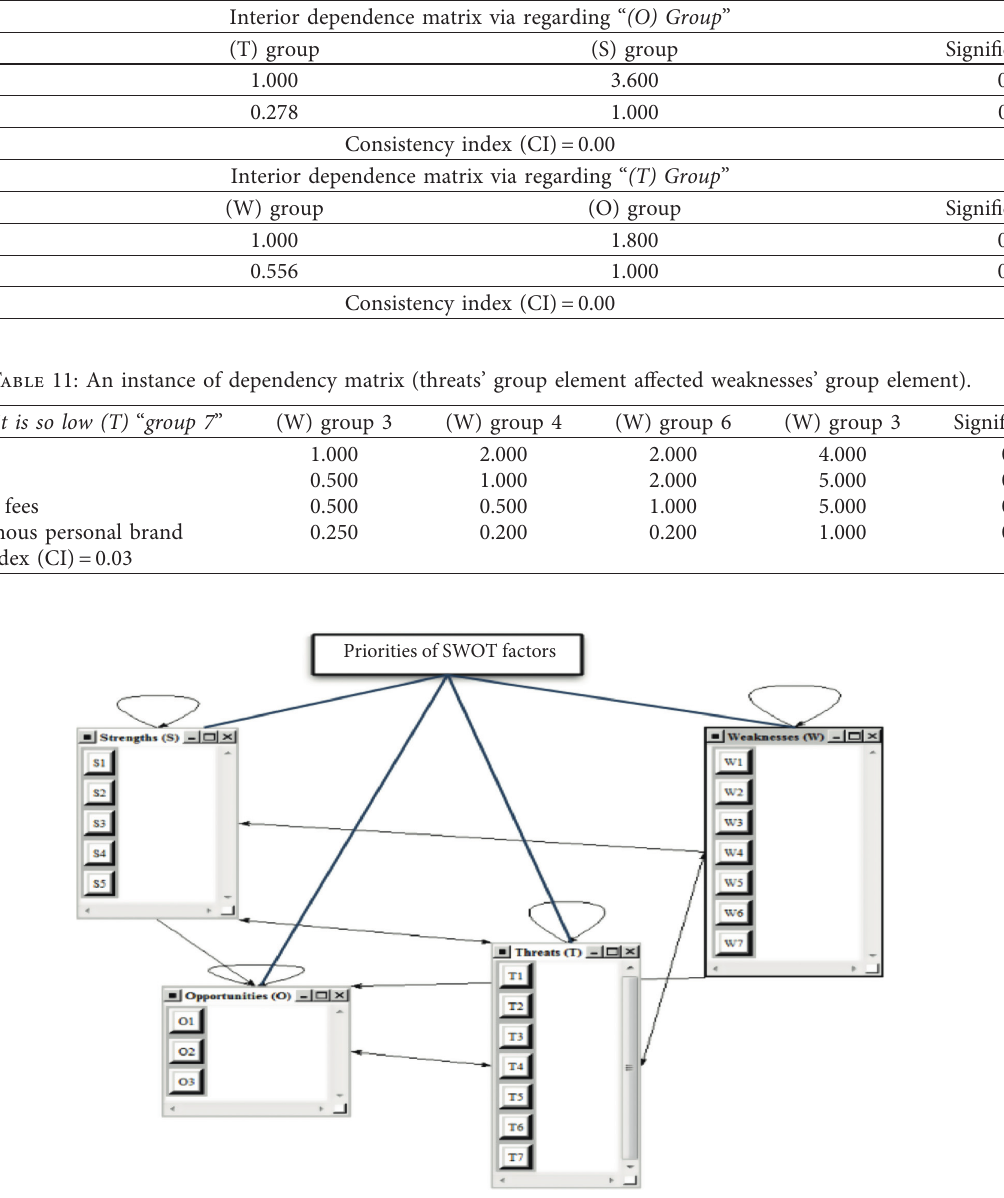
Figure 5: The network sketch of